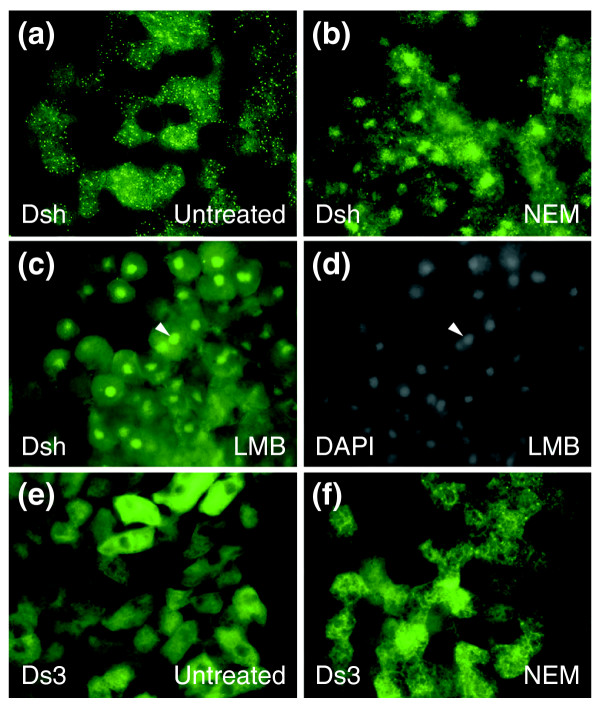
Accumulation of Dsh in the nucleus in the absence of nuclear export. (a-d) Dsh-GFP RNA (0.7 ng) was injected into two animal blastomeres of 4–8 cell embryos. Animal caps were excised at stage 10 and then left (a) untreated or (b) treated with 10 mM NEM or (c,d) 50 ng/ml leptomycin B (LMB), fixed and examined for GFP fluorescence. (a) Dsh-GFP is mainly localized to vesicular structures in the cytoplasm. In the presence of (b) NEM or (c) LMB, Dsh-GFP accumulates in the nucleus, as supported by (d) DAPI staining of nuclei in the same field as in (c). Nuclear staining is marked by arrowheads (c,d). (e,f) The Ds3 construct, lacking amino acids 334–381, remained in the cytoplasm in the (e) absence or (f) presence of NEM.